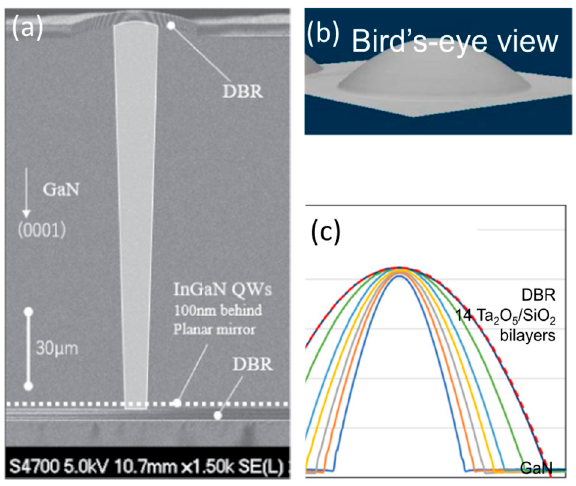
Figure 10. ( a ) Cross-sectional SEM image observed for the device used for the optical pumping test. The light grey shape is a schematic representation, of the area for the resonant modes in this device. ( b ) Laser scanning confocal microscope images of lenslets (diameter = 55 µ m) fabricated on the (000-1) plane of GaN wafer. ( c ) Cross-sectional TEM image of the curved mirror of the device used for an optical pumping test. [93] Copyright 2018 Scientific Reports.